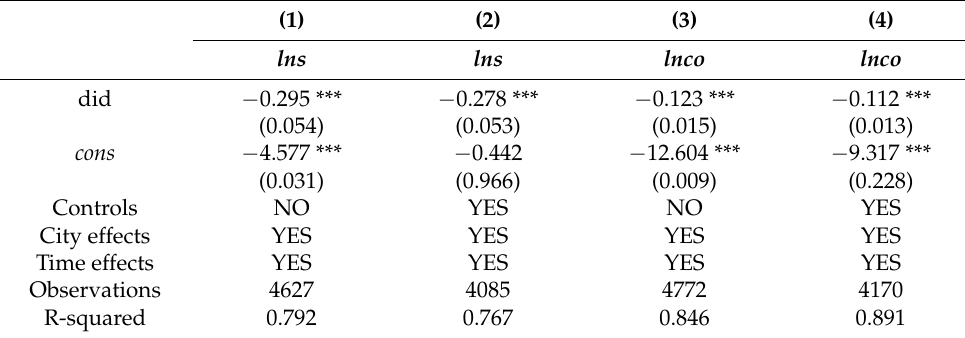
Table 2. Overall impact of EIPs on